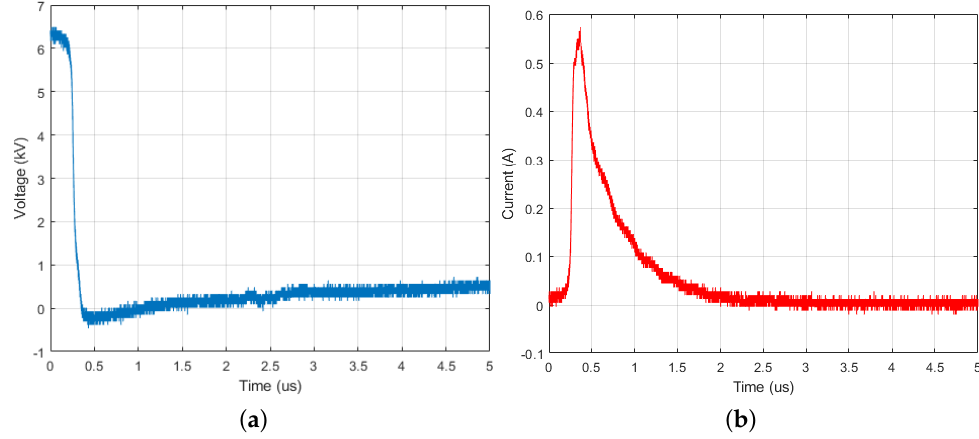
Figure 10. Experimentally obtained ( a ) voltage and ( b ) current response of plasma